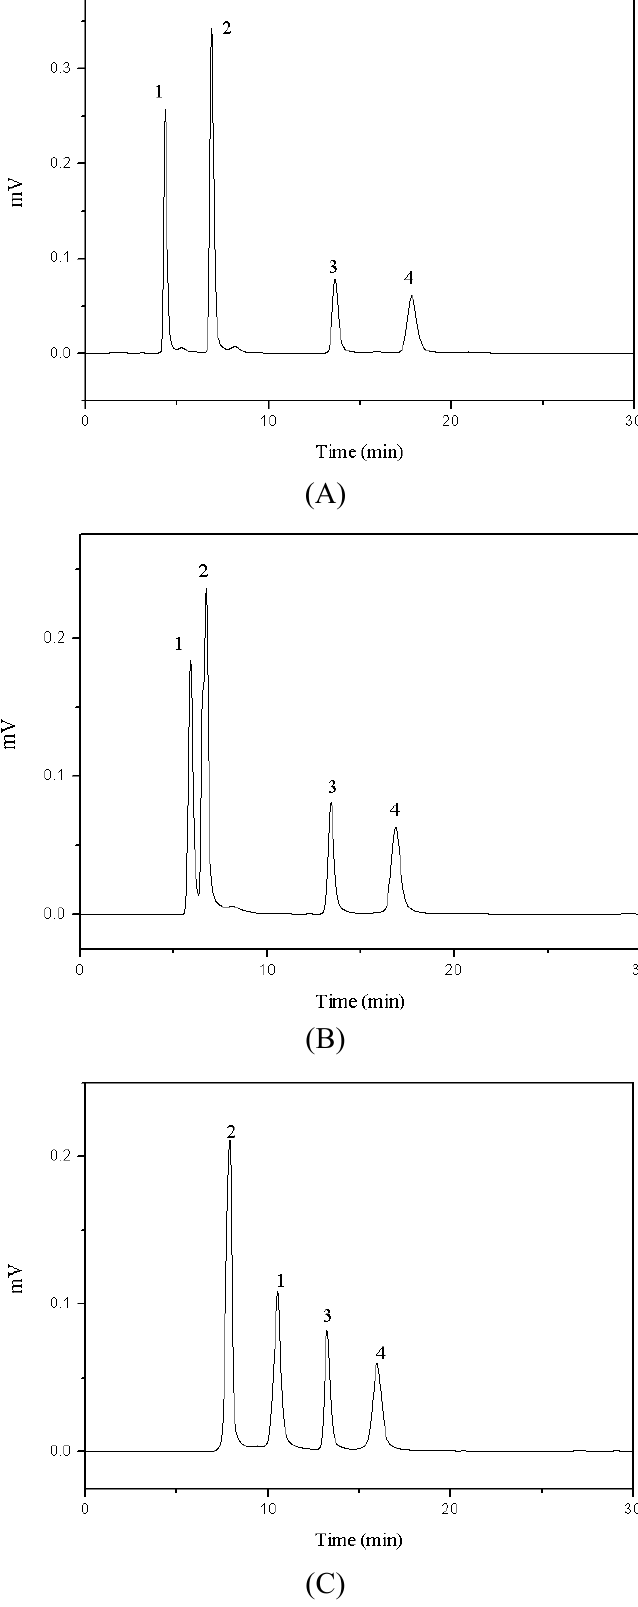
Figure 7. Chromatograms of the four target compounds with 0.01 mol/L of ionic liquid as the mobile phase additives. (A) [BMIM][BF